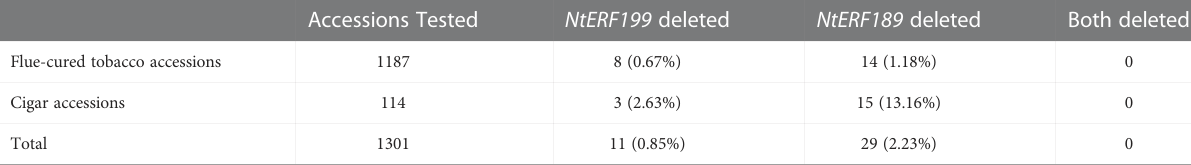
TABLE 3 Distribution of deletion mutation of NtERF189 and NtERF199 in germplasm